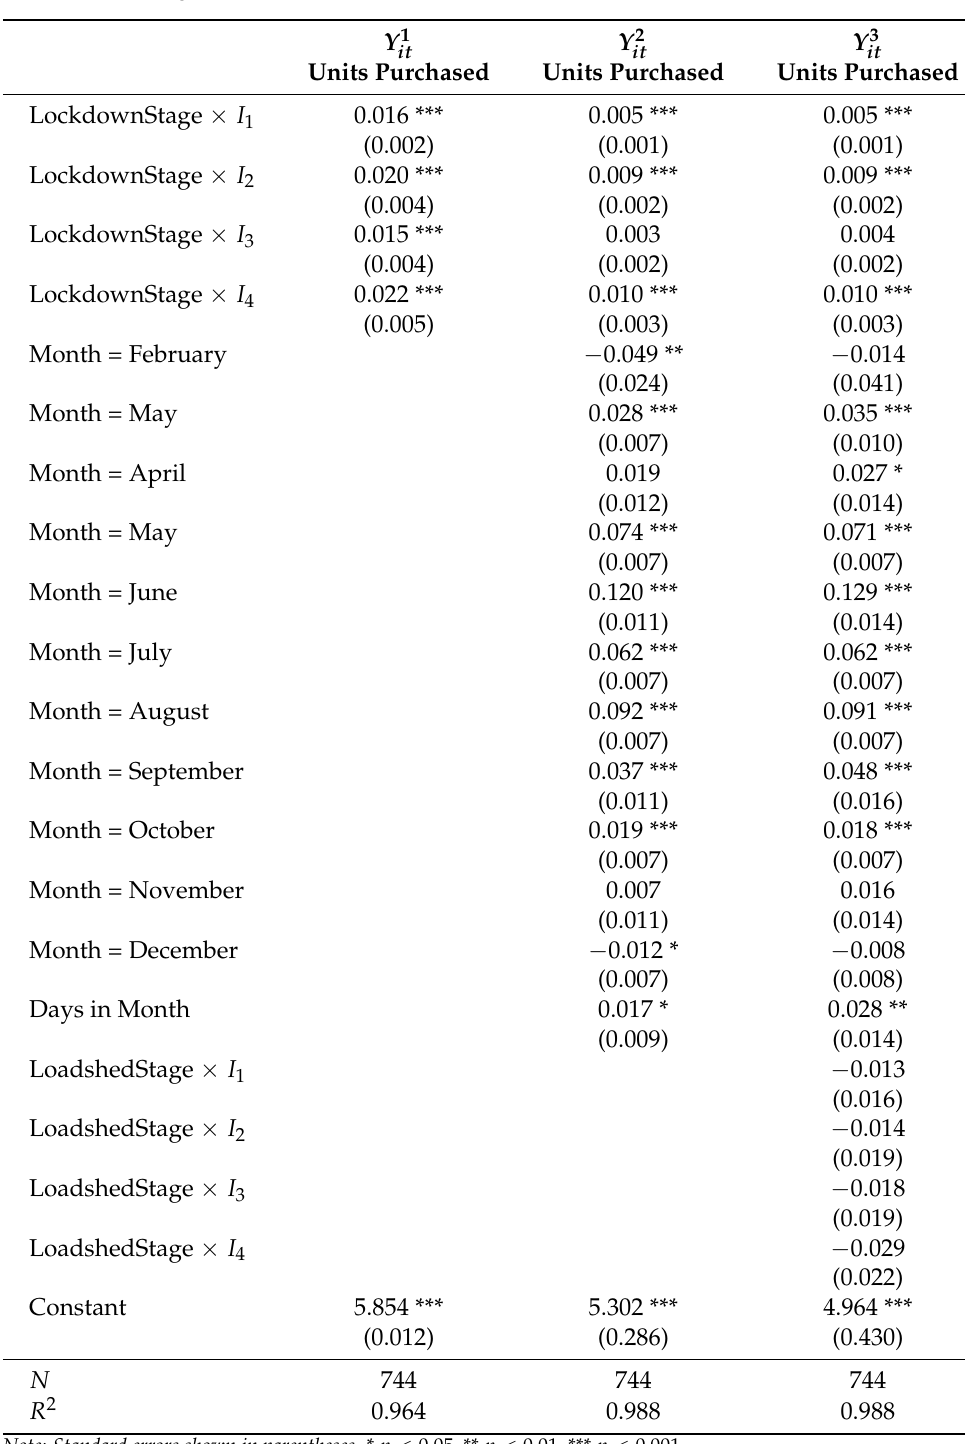
Table 1. Linear regression